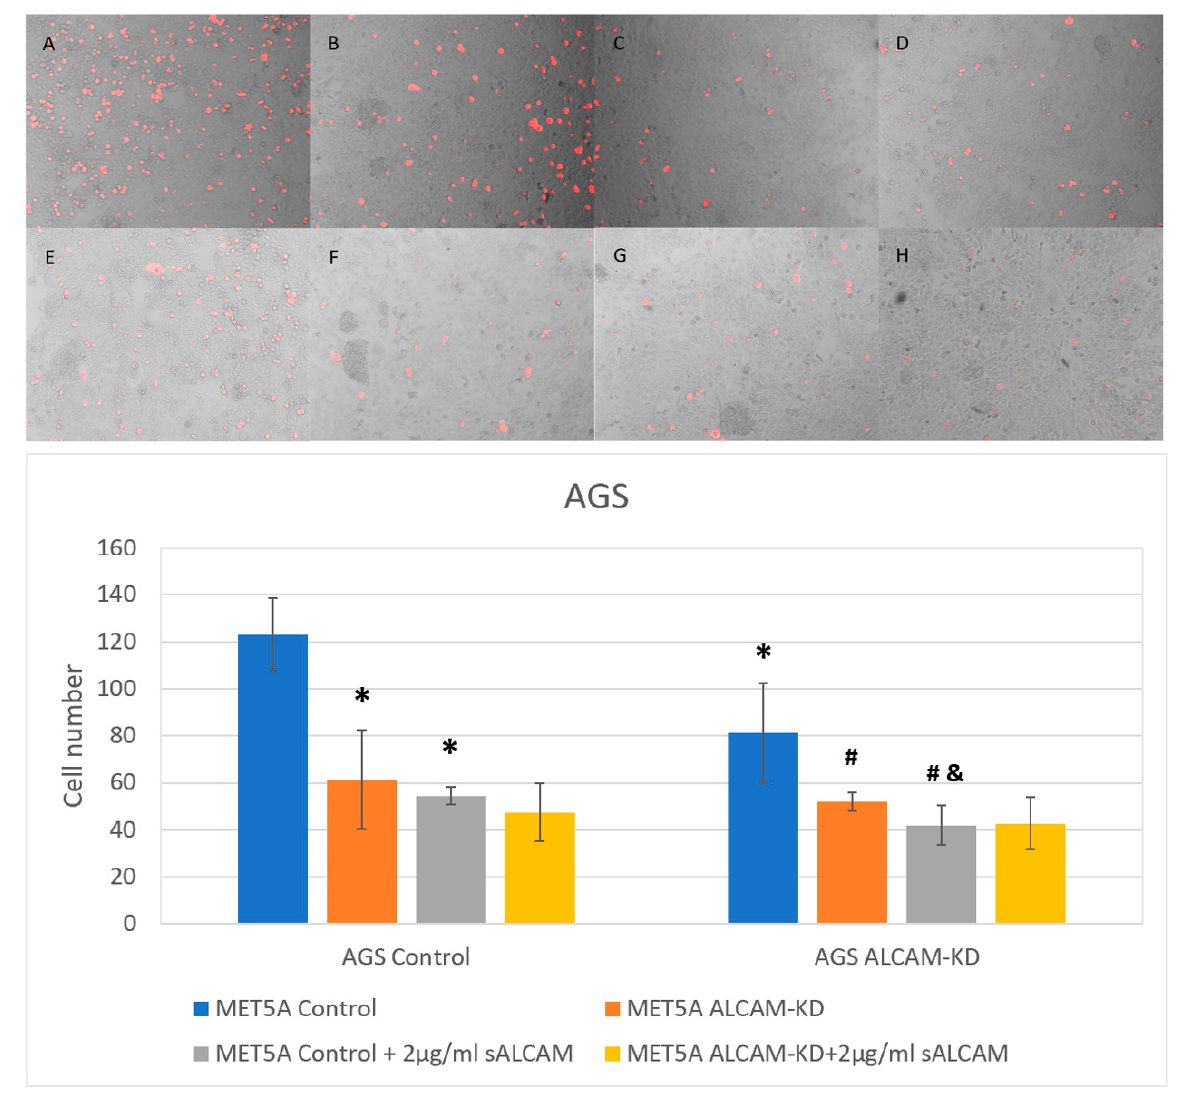
Figure 10. Interaction between gastric cancer cell line AGS and mesothelial cell line MET5A as determined by the DiI based assays. ( Top ): Representative images (×10 magnification) of gastric cancer cells (AGS Control and ALCAM knockdown cells) adherence to mesothelial cells (MET5A Control and ALCAM knockdown cells). ( A – D ) represent wells without any treatment and E-H represent wells treated with 2 µg/mL sALCAM. ( A , E ): MET5A control + AGS control; ( B , F ): MET5A control + AGS ALCAM knockdown; ( C , G ): MET5A ALCAM knockdown + AGS Control; ( D , H ): MET5A ALCAM knockdown + AGS ALCAM knockdown. ( Bottom ): Graphical representation of pancreatic cancer cells (AGS Control and ALCAM knockdown cells) adherence to mesothelial cells (MET5A Control and ALCAM knockdown cells). *: Groups which showed significantly differences compared with “MET5A Control + AGS Control” group ( p < 0.05). #: Groups which showed significantly differences compared with “MET5A Control + AGS ALCAM-KD” group ( p < 0.05); &: Groups which showed significantly differences compared with” MET5A Control + AGS Control + sALCAM” group ( p <